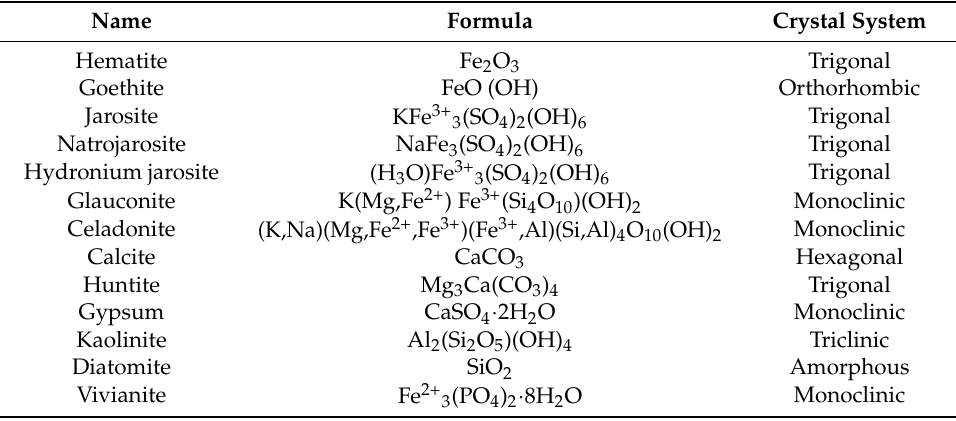
Table 2. Red, yellow, green, white and blue minerals encountered in earth pigments.